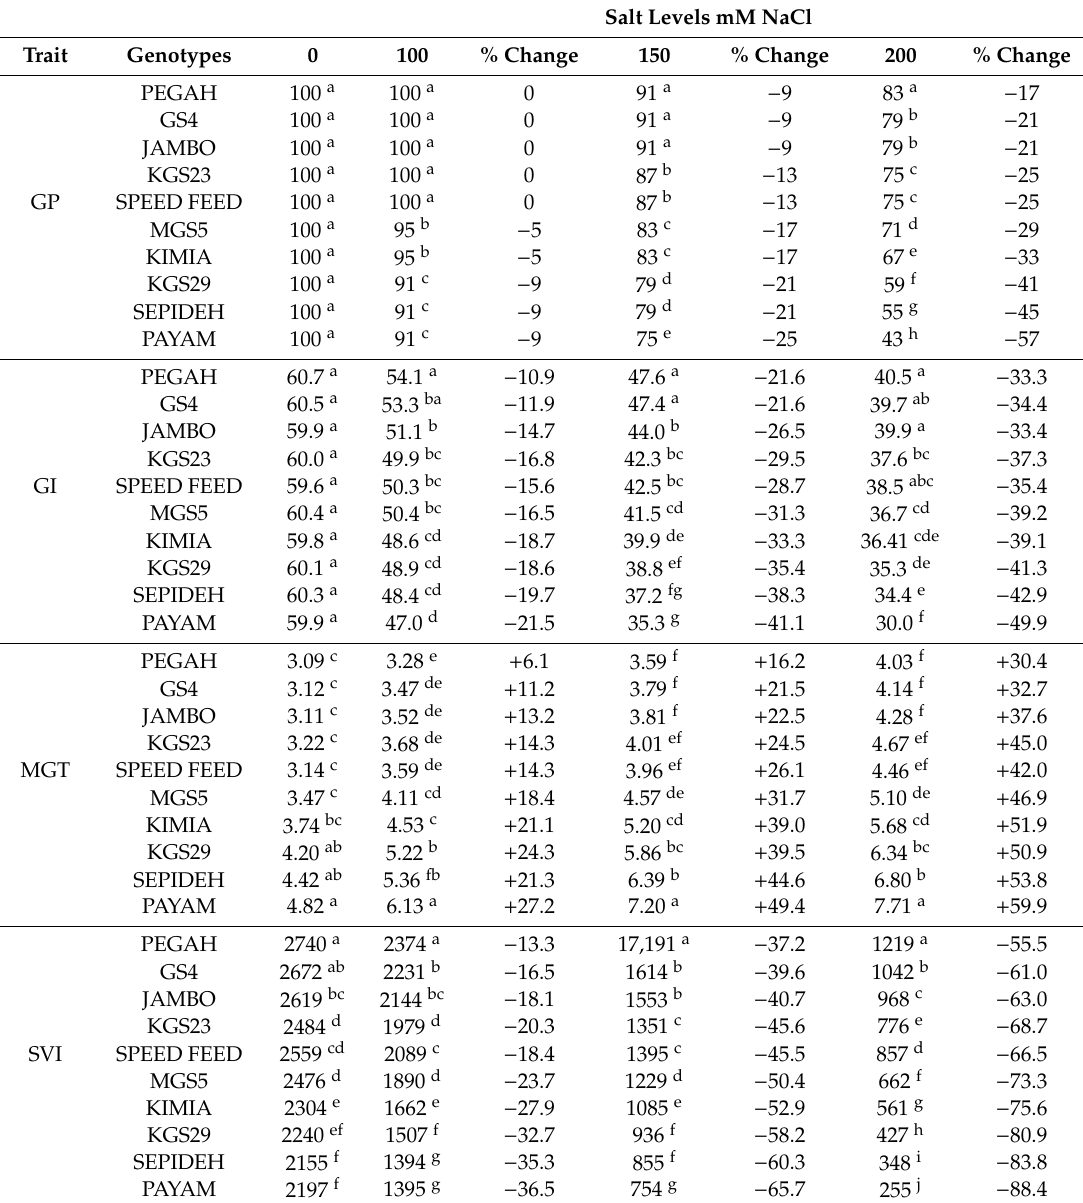
Table 2. Germination parameters of ten sorghum genotypes in four salt treatments